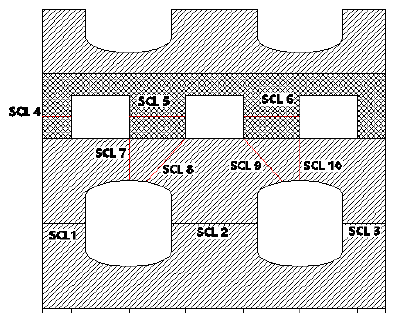
Figure 6. Stress classification lines (SCLs) for stress linearization method.